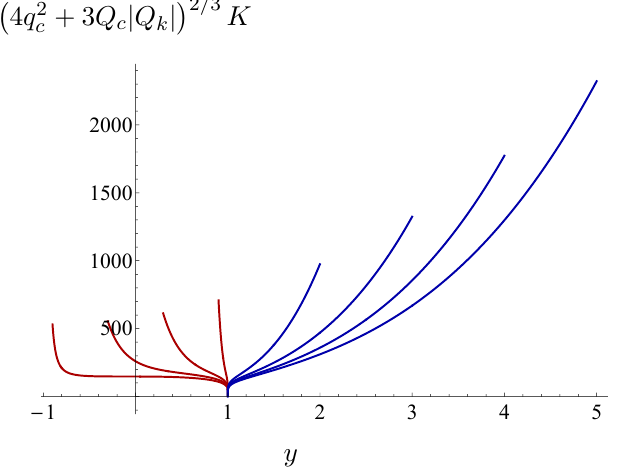
solutions (left, red 8 solutions (right, blue curves) 8